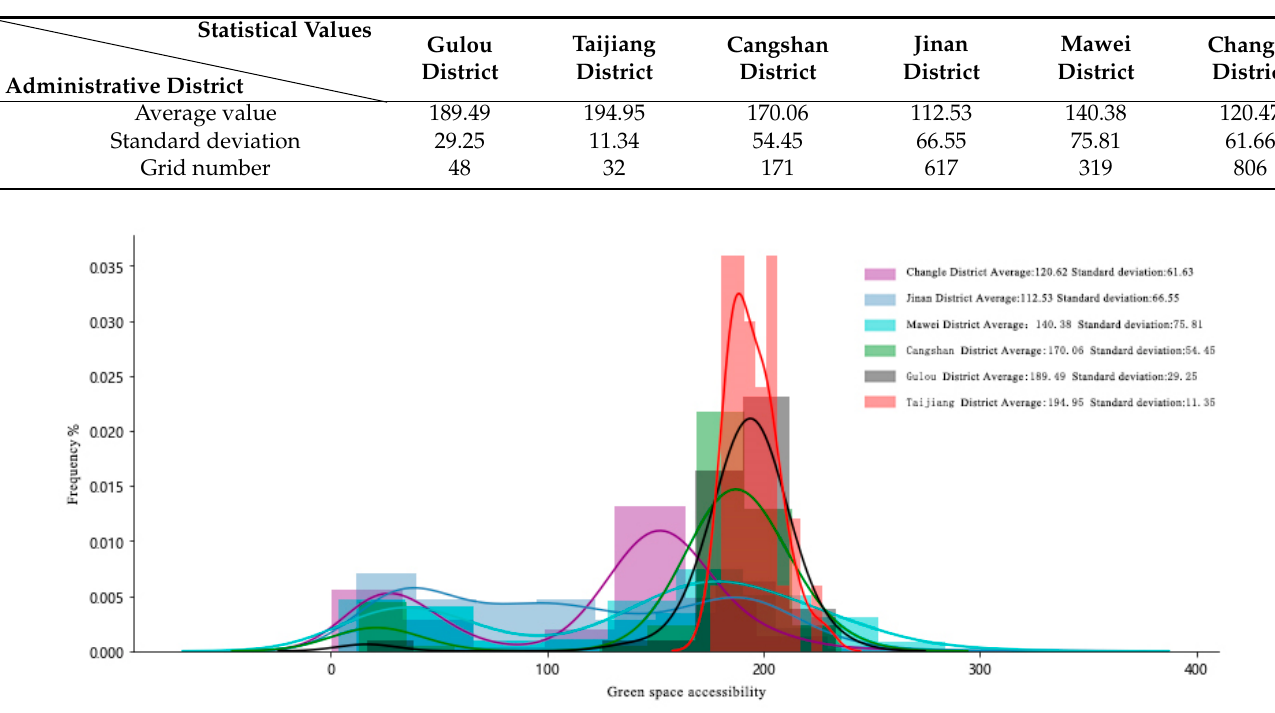
Figure 13. Distribution of accessible green spaces in Fuzhou City. Table 8. Statistical descriptions of green space accessibility in urban areas of Fuzhou.